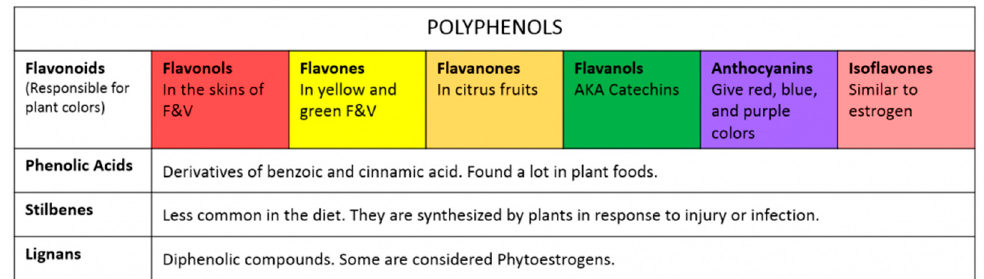
Figure 4. Different polyphenol colors and correspondent fruits and vegetables (F&V—fruits and vegetables; AKA—also known as). Retrieved from Emerson Ecologics [18].